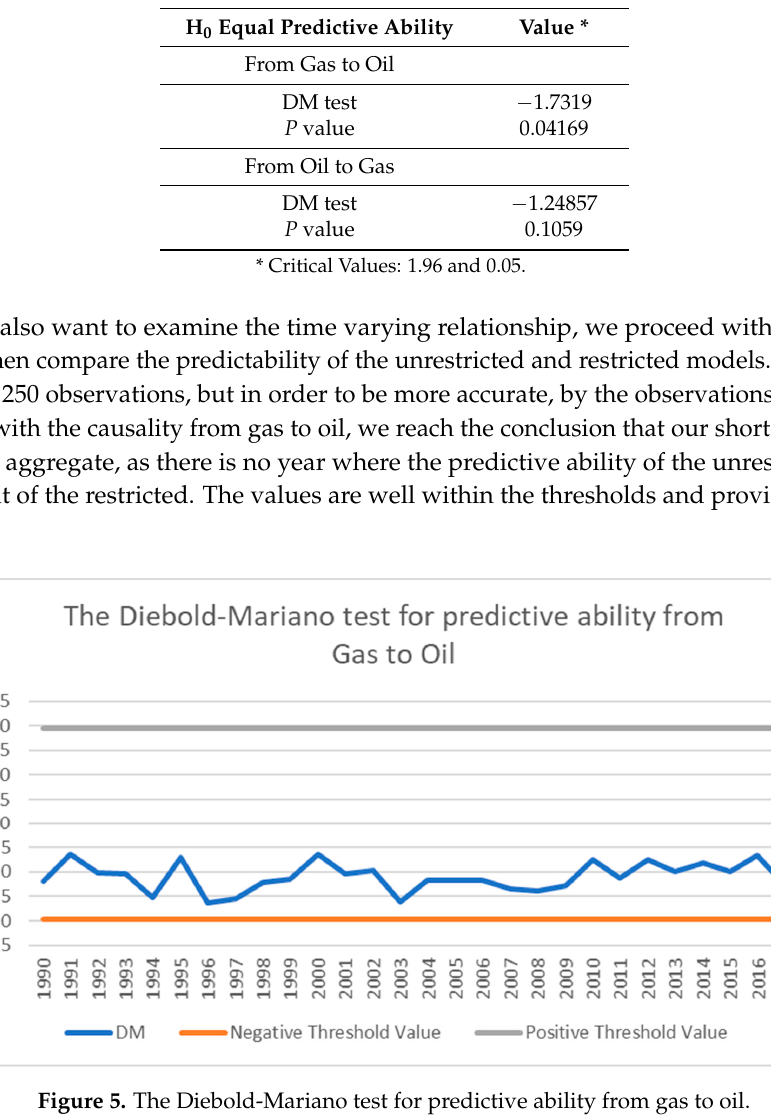
Table 4. Diebold and Mariano tests–full sample.